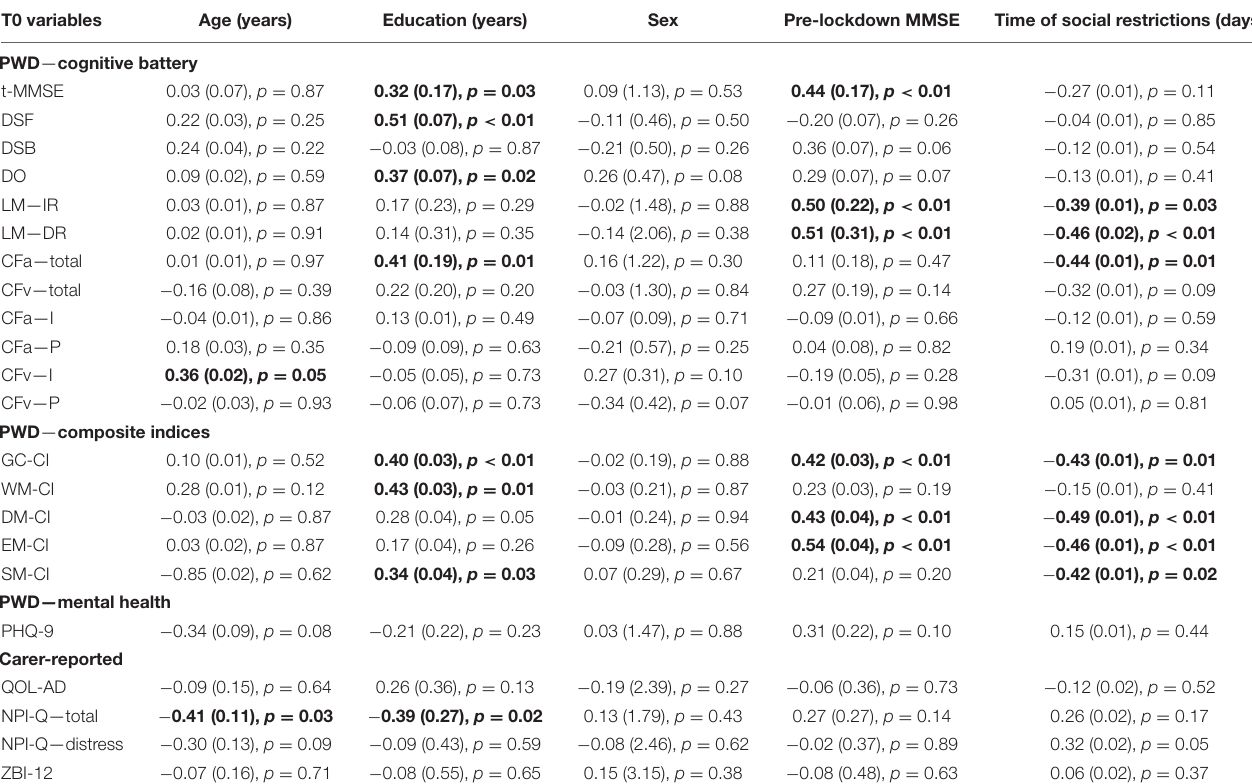
TABLE 3 | Results of the multivariate multiple regression models ( β s and standard errors) to predict cognitive and clinical characteristics of PWD and carers at T0. T0